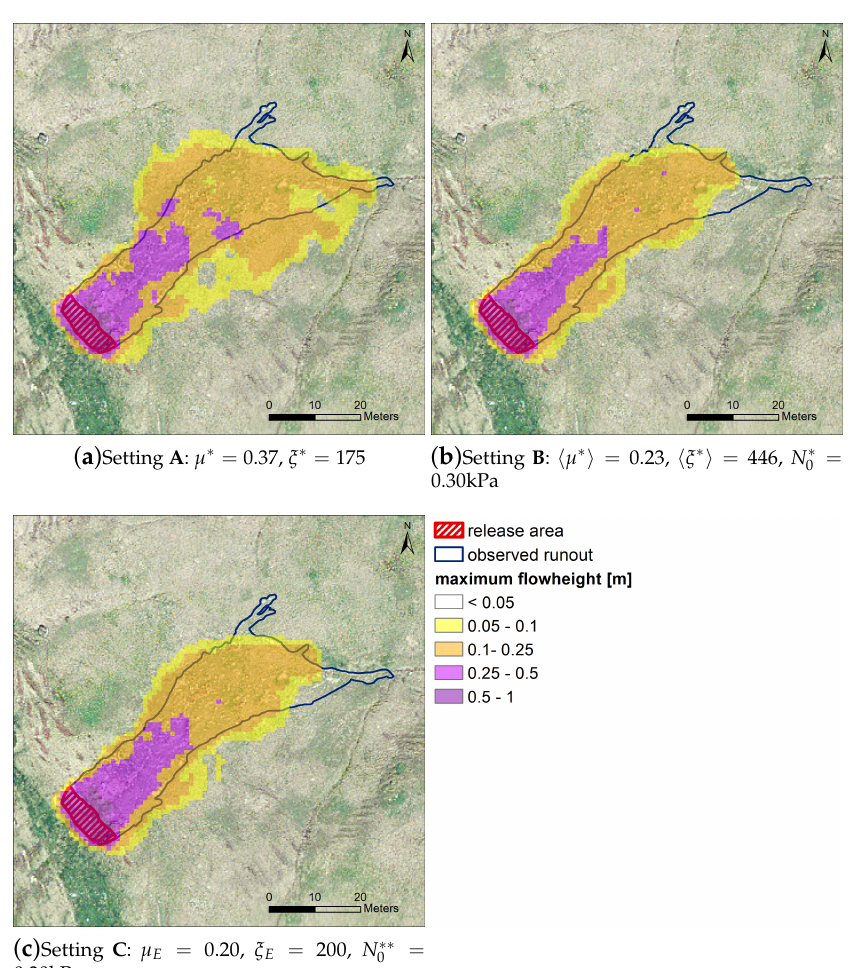
Figure 3. Simulation results of hillslope debris-flow event HM4 (Eriz) for all parameter settings. Observed release area and runout zone are shown with red and blue lines, respectively. Typical µ and ξ parameters for different mass movements are plotted in Figure 4 along with the best-fit Voellmy-type friction parameters of the compiled hillslope debris-flow events used in this study (Setting A